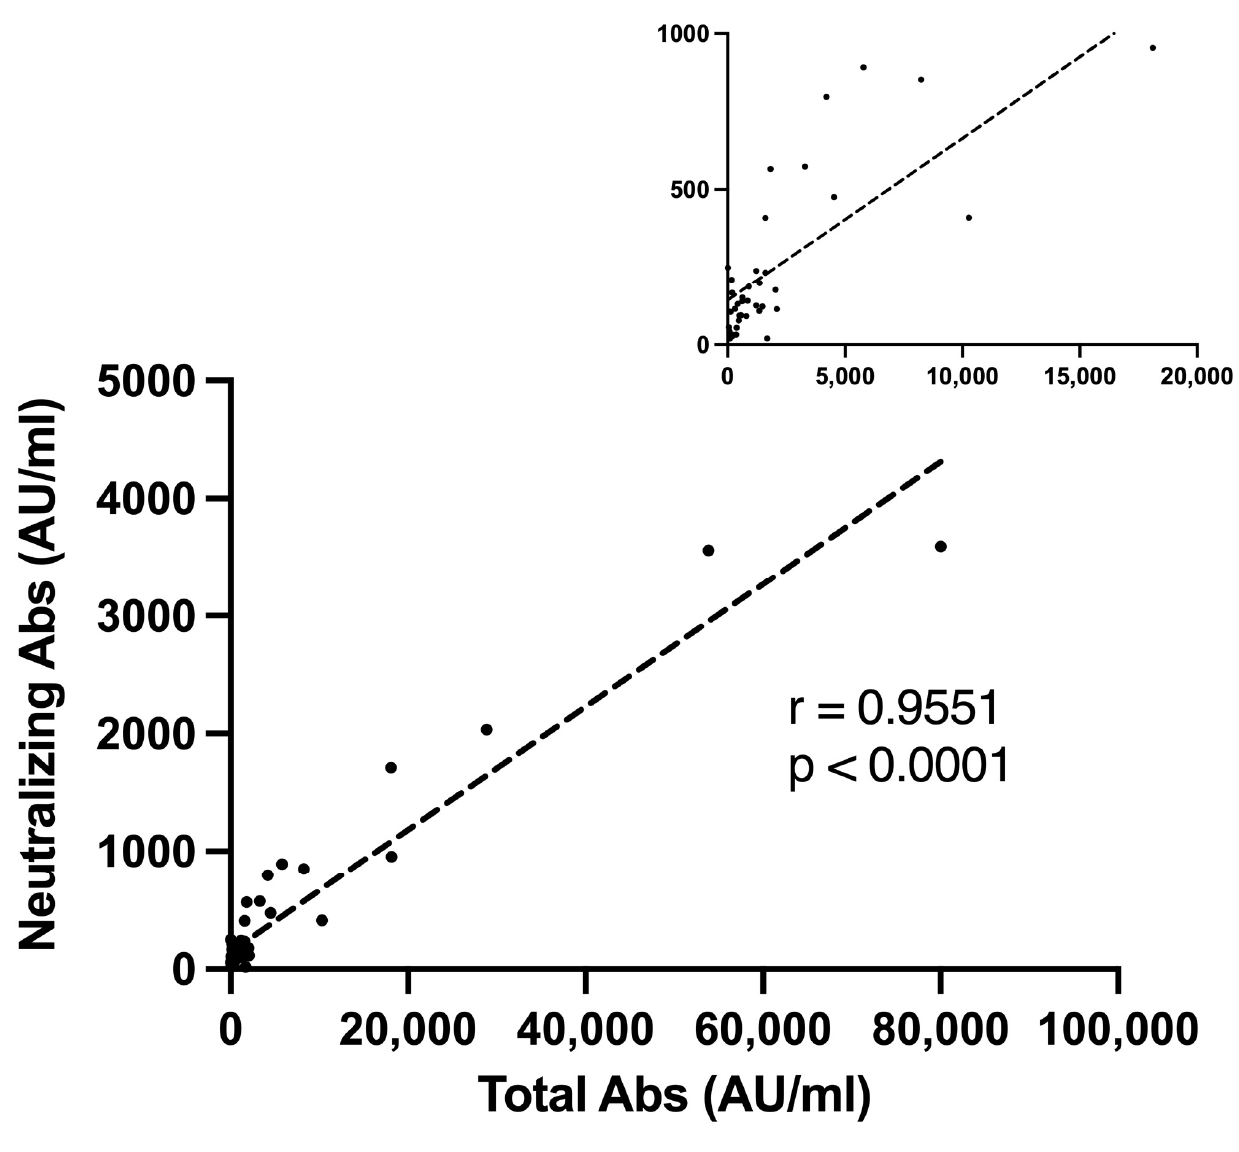
Figure 2. Neutralizing antibodies and seropositive s-IgG titer Correlation. A Pearson correlation plot representing the correlation between S1-IgG antibody levels (AU/mL) and neutralizing antibody titer among vaccinated lung transplant recipients. The small upper Pearson correlation plot represents a magnified view with a scale of 5000 Total Abs (AU/mL). Abs, antibodies; AU, antibody units. Patients with neutralizing antibodies were younger (t = 2.047, p = 0.023) and were